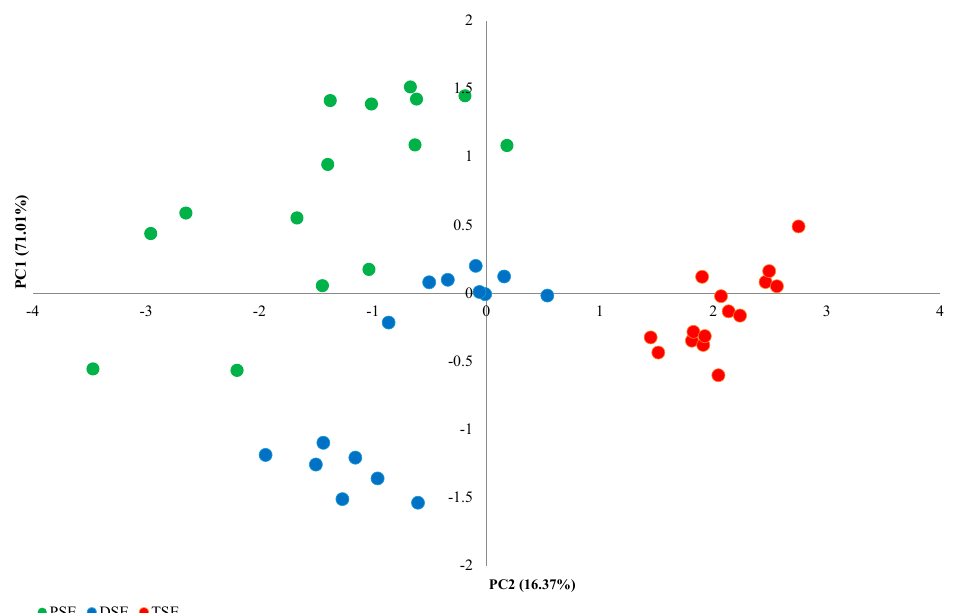
Figure 2. PCA analysis of variability between PSE (obtained through indirect somatic embryogenesis), DSE (secondary somatic embryos induced on the hypocotyls of PSE) and TSE (obtained through direct somatic embryogenesis from DSE) sets of regenerates based on morphological traits.